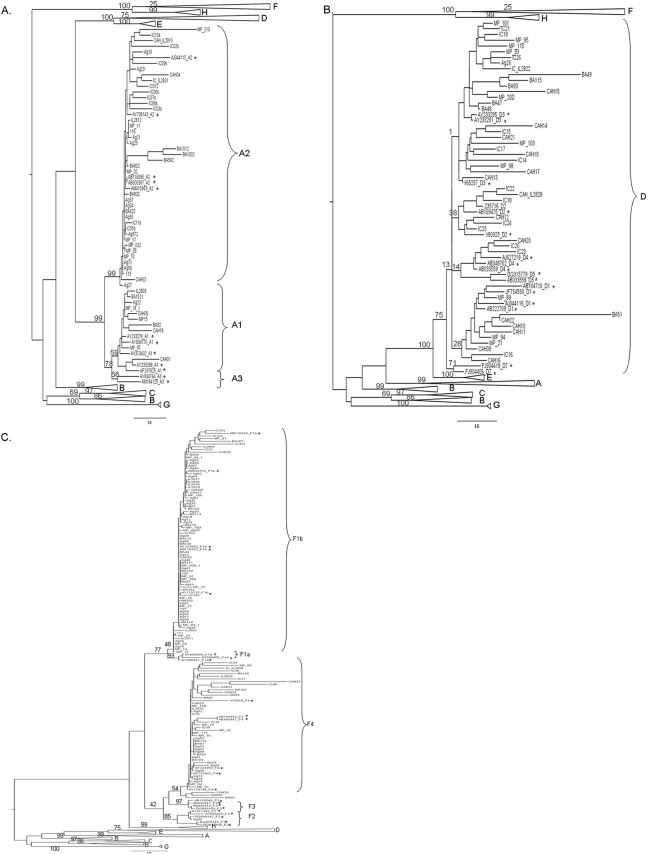
Phylogenetic-tree showing detailed genotype A (A), D (B) and F (C) branches.Maximum Likelihood phylogenetic-tree including the 234 Argentine HBV samples in this study, showing: (A) the whole tree with detailed genotype A branch; (B) genotype D branch; and (C) genotype F branch. Reference samples are marked with an asterisk. Genotypes and subgenotypes are indicated in capital letters. Numbers at each node correspond to bootstrap values obtained with 1000 replicates; only nodes corresponding to main groups are shown, for clarity purposes. Horizontal branches are drawn to scale.